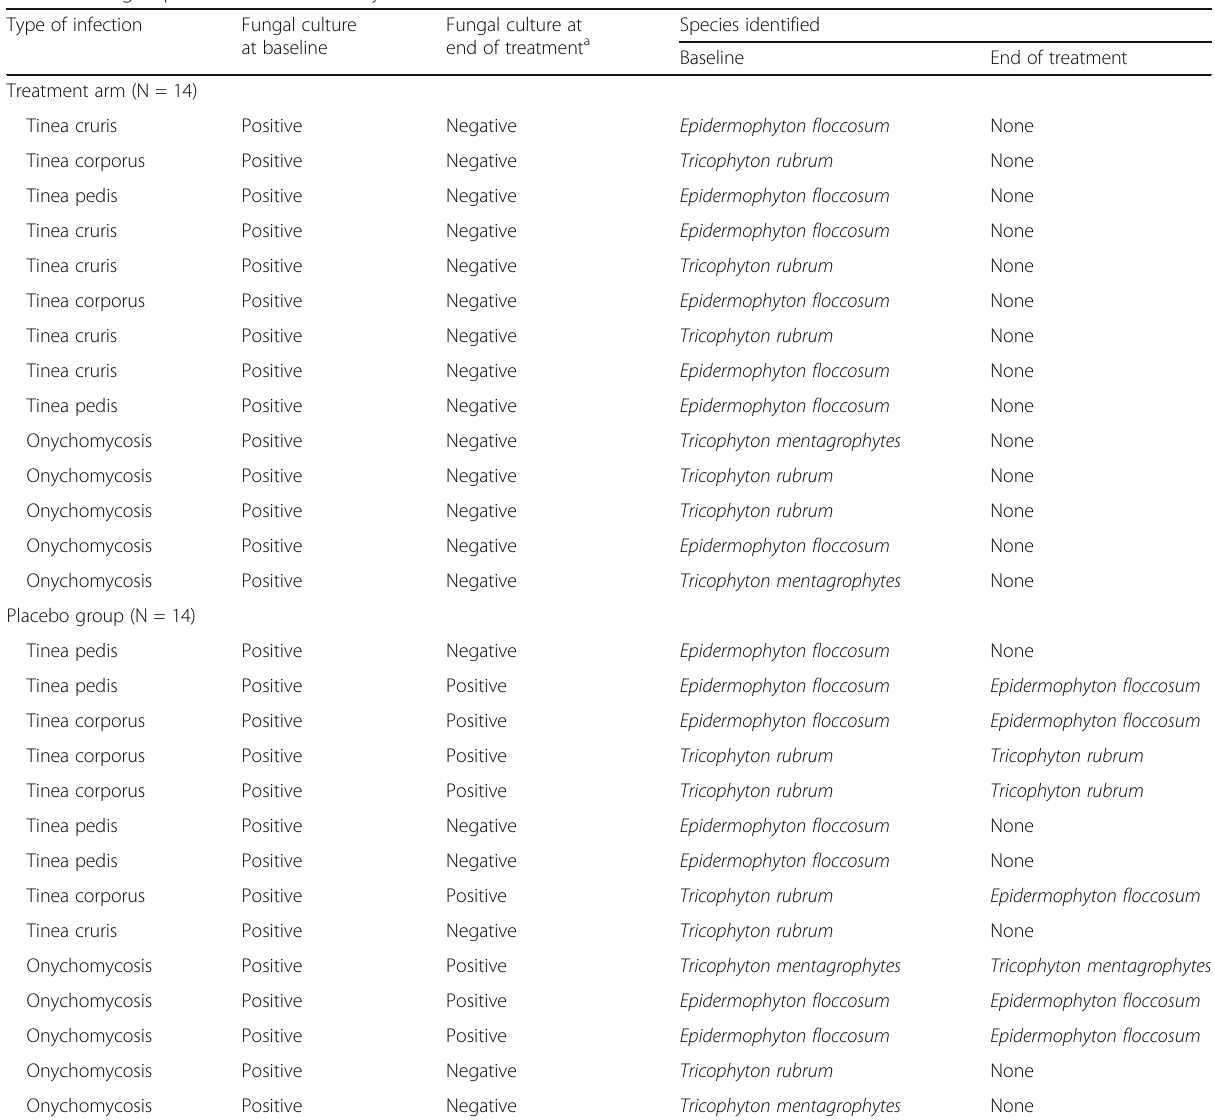
Table 3 Fungal species identified in subjects Type of infection Fungal culture